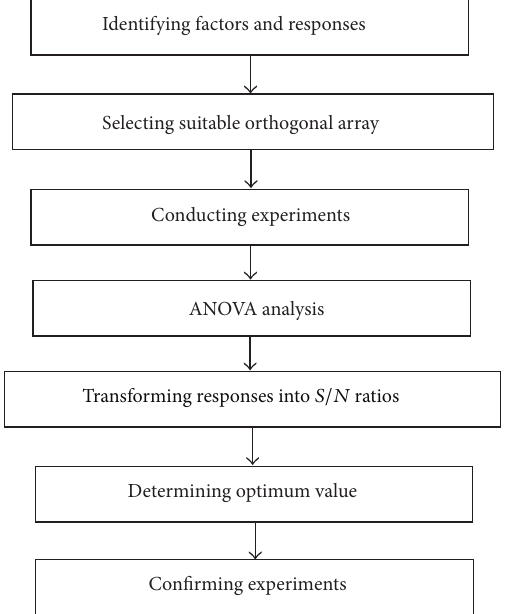
Figure 3: Taguchi orthogonal